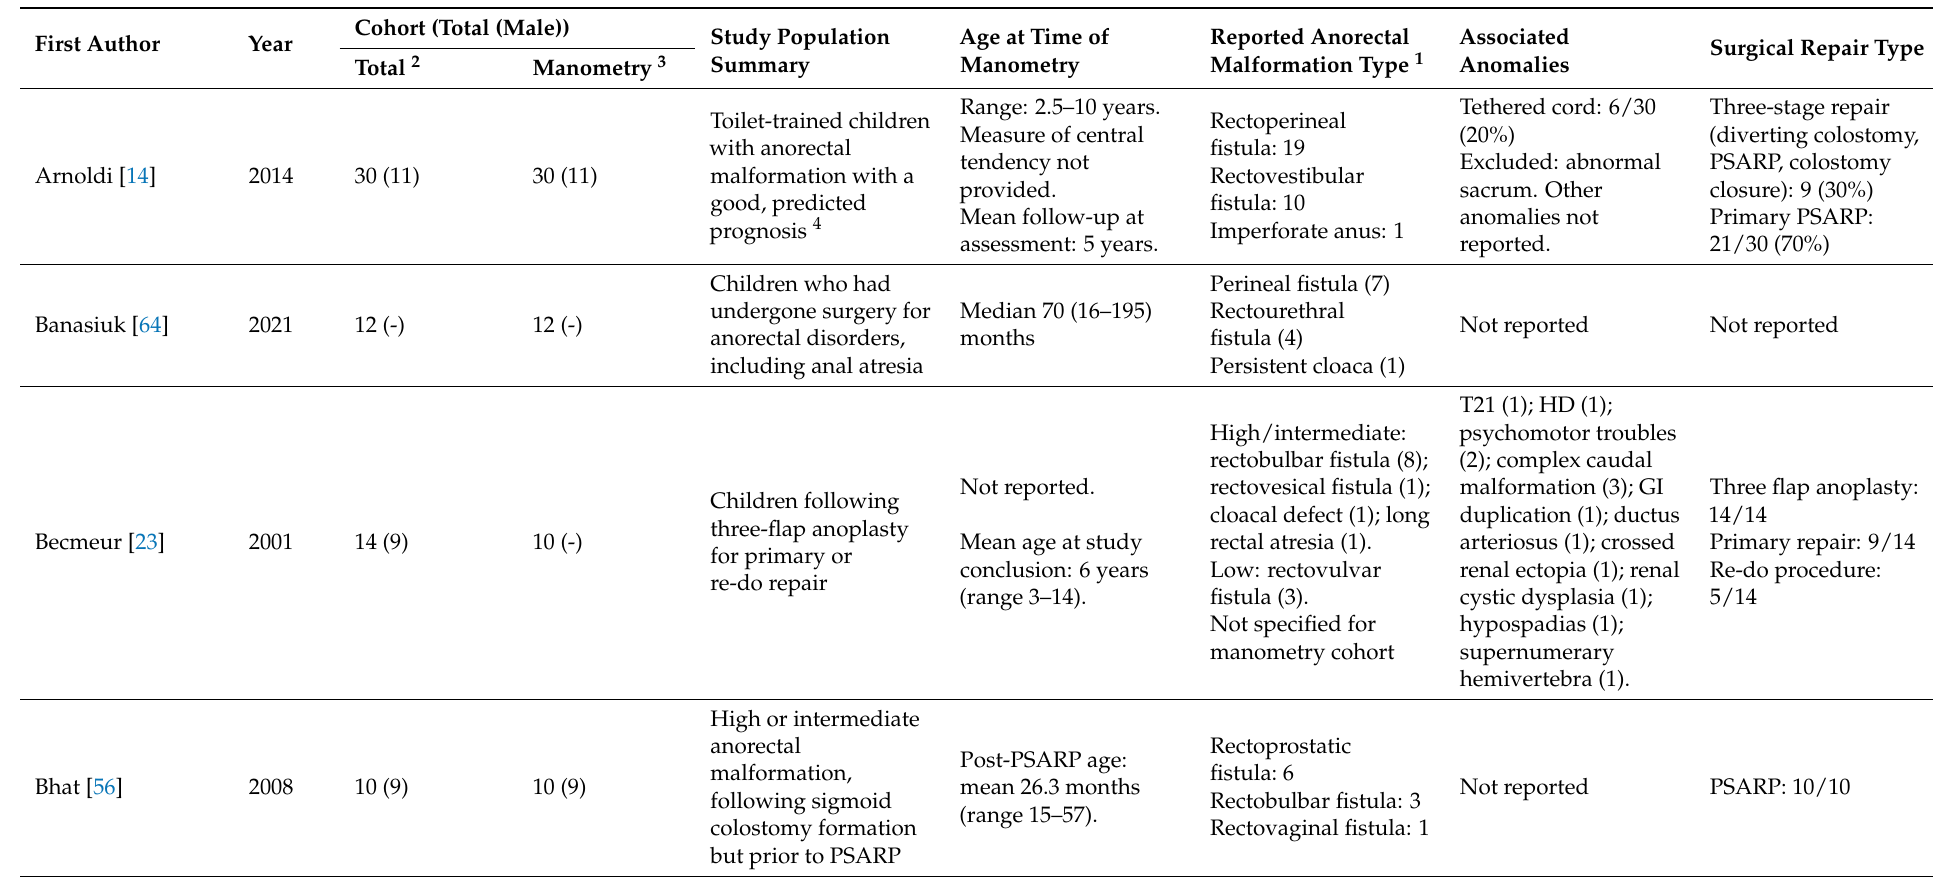
Table 1. Clinical characteristics of included